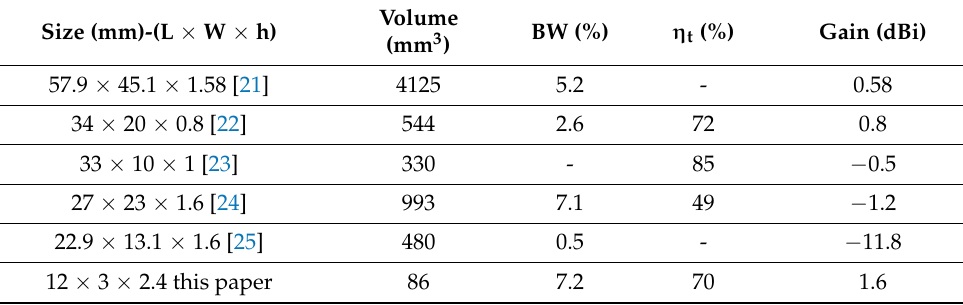
Table 1. Comparison of several single-band antennas operating at 900 MHz. Size (mm)-(L × W ×